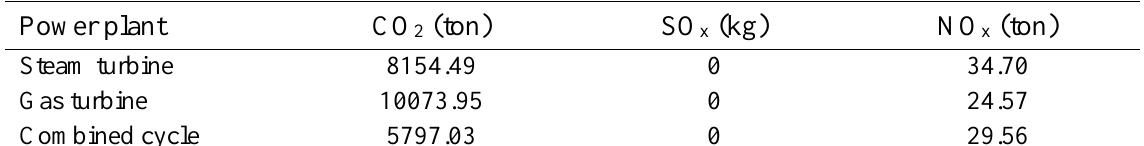
Table 6. Pollution emissions associated with generating 𝐸 ∗ by gas as the input fuel in different power plants.